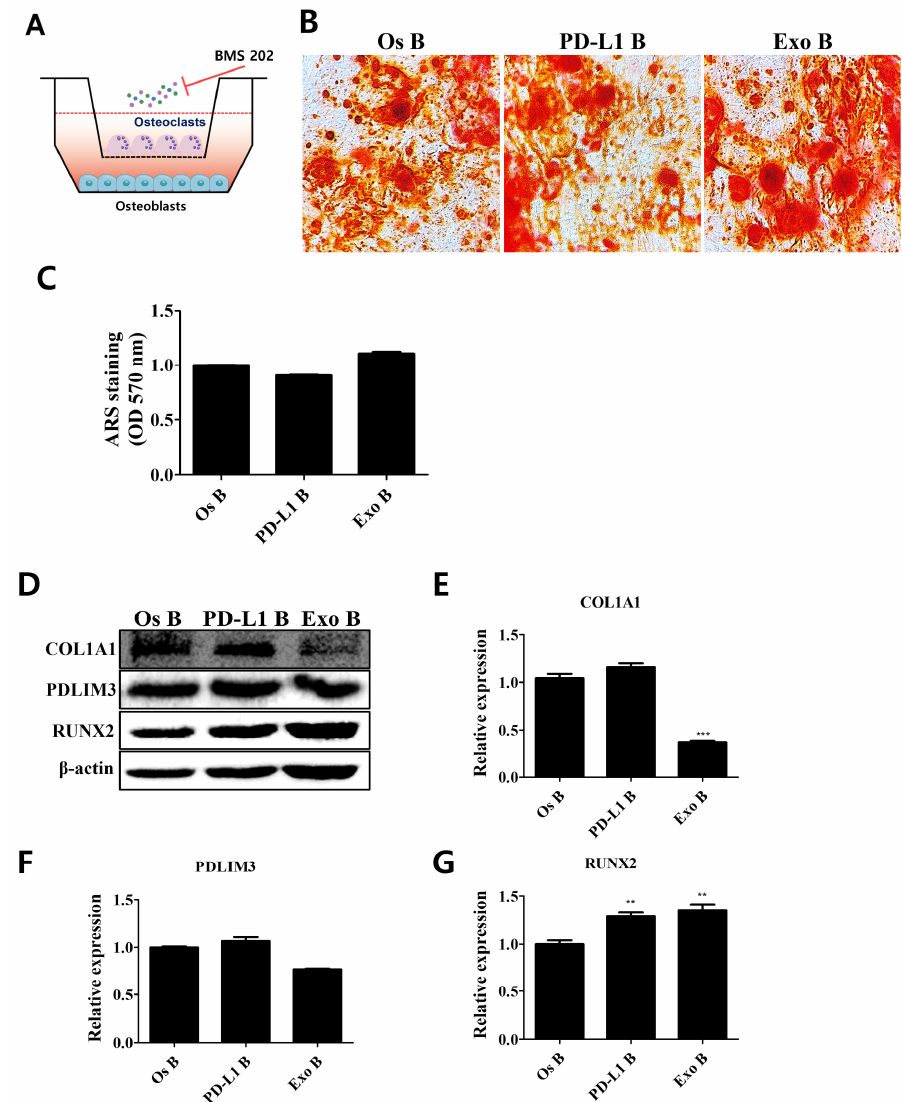
Figure 7. Attenuation of osteogenic properties in cocultured osteoblasts via inhibition of PD-1/PD-L1 interaction. ( A ) PD-1/PD-L1 interaction was inhibited in the cocultured environment. ( B ) Mainte- nance of bone mineralization in cocultured osteoblasts. ( C ) Stained calcium deposits were dissolved and quantified. N = 5 trials per sample and control. ( D ) Attenuation of the expression levels of pro- teins mediating osteogenic properties upon inhibition of PD-1/PD-L1 interaction. Relative expression levels of ( E ) COL1A1, ( F ) PDLIM3, and ( G ) RUNX2. N = 3 trials per sample and control. Data are presented as mean ± SEM. ** p < 0.01, and *** p < 0.001, compared with the Os B group. Os: osteoblasts (cocultured); PD-L1: PD-L1 (500 ng/mL); Exo: exosome (10 μ g/mL, 2.5 × 10 8 parti- cles/mL); B: BMS 202 (10 μ M).